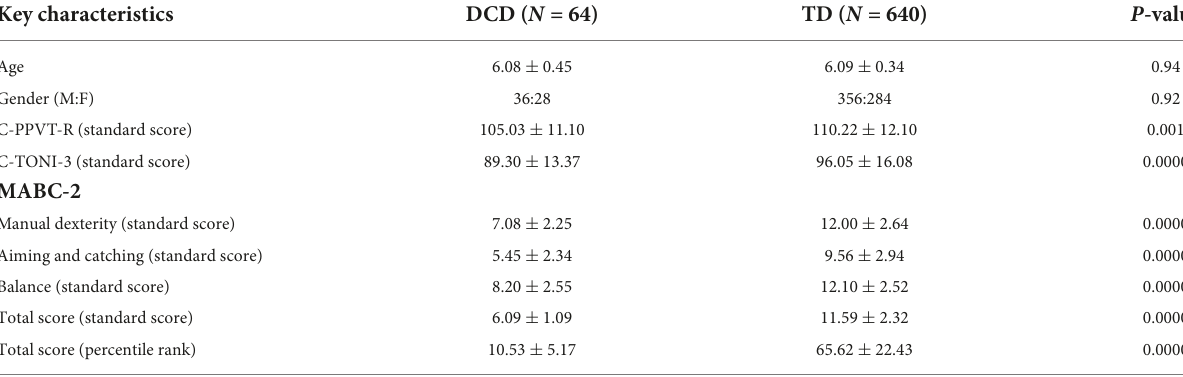
TABLE 1 The results of the statistical tests that compared key characteristics of the DCD children and the TD